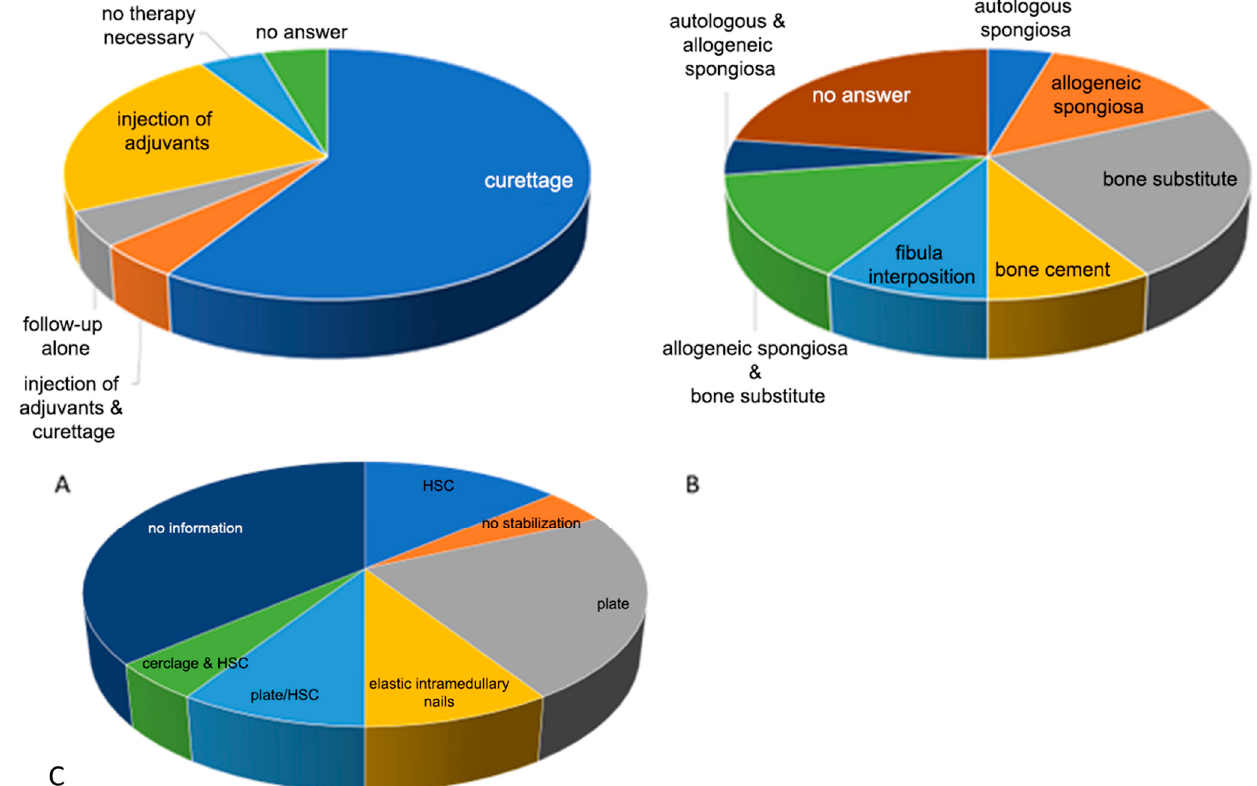
Figure 5. ( A ) As local therapy, the following were recommended by the respondents: curettage, 68.2%; adjuvant injection and curettage, 4.5%; follow-up alone, 4.5%; injection of adjuvants, 22.7%; no therapy necessary, 4.5%; and no information, 4.5%. ( B ) For defect filling, autologous spongiosa was recommended by 4.5% of the respondents; allogeneic spongiosa, by 13.6%; bone substitute, by 27.3%; bone cement, by 9%; fibula interposition, by 9%; allogeneic spongiosa and bone substitute, by 13.6%; and autologous and allogeneic spongiosa, by 4.5%. Of the respondents, 22.7% gave no answer. ( C ) For osteosynthesis/stabilisation, most of the 22 hospitals recommended surgical stabilisation (40.9%), 9% of the clinics preferred immobilisation with an HSC only; 9% did not commit themselves and recommended a procedure (plate osteosynthesis or HSC as a secondary alternative) depending on the findings and completion of the cyst removal and filling; and 4.5% saw no need for immobilisation or stabilisation. Surgical stabilisation using plate osteosynthesis (27%), elastic intramedullary nails (9%), or cerclage and additional HSC immobilisation were mentioned. Of the participating hospitals, 36.4% did not provide any information on this question.